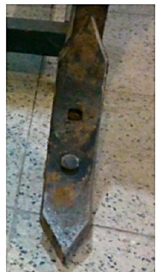
Figure 3. Chisel cultivator blade used in the research.